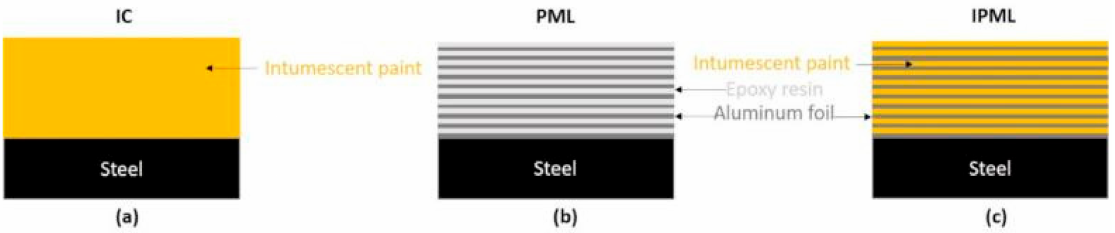
Figure 1. Illustration of ( a ) intumescent coatings (IC), ( b ) polymer metal laminates (PML), and ( c ) intumescent polymer metal laminates (IPML) systems.